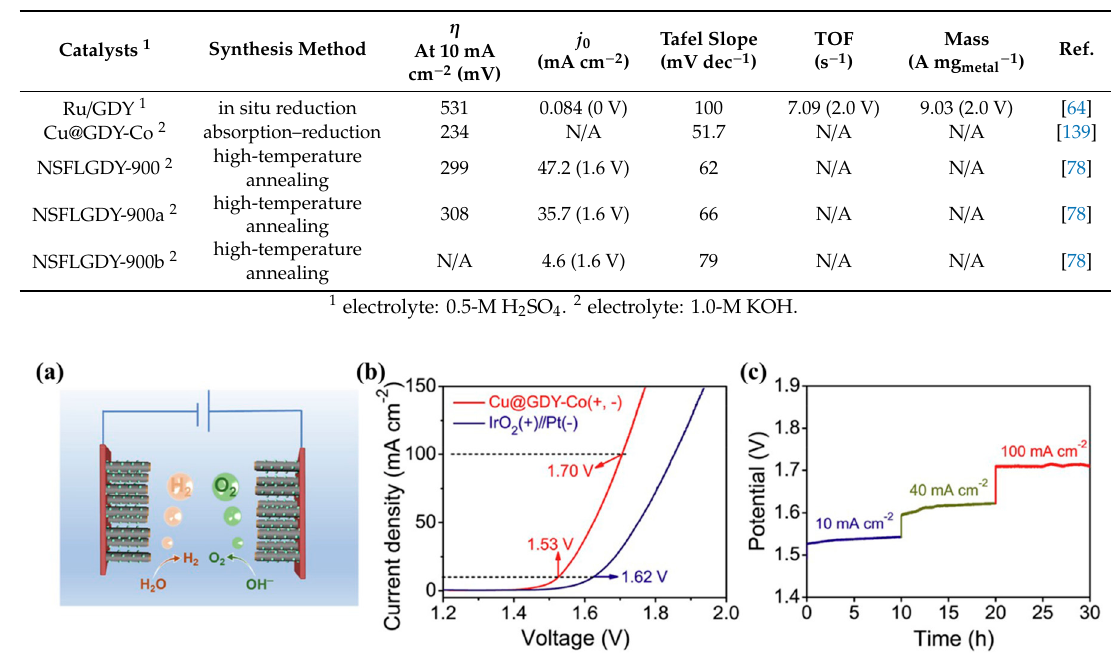
Figure 17. Overall water splitting schematic illustration and electrochemical characterizations of Cu@GDY-Co. ( a ) Schematic illustration of the electrolyzer using Cu@GDY-Co as both cathode and anode; ( b ) polarization curves for overall water splitting; ( c ) chronopotentiometric curve of water electrolysis recorded at the current density of 10, 40 and 100 mA cm − 2 (reproduced with permission from [139]. Copyright Elsevier,